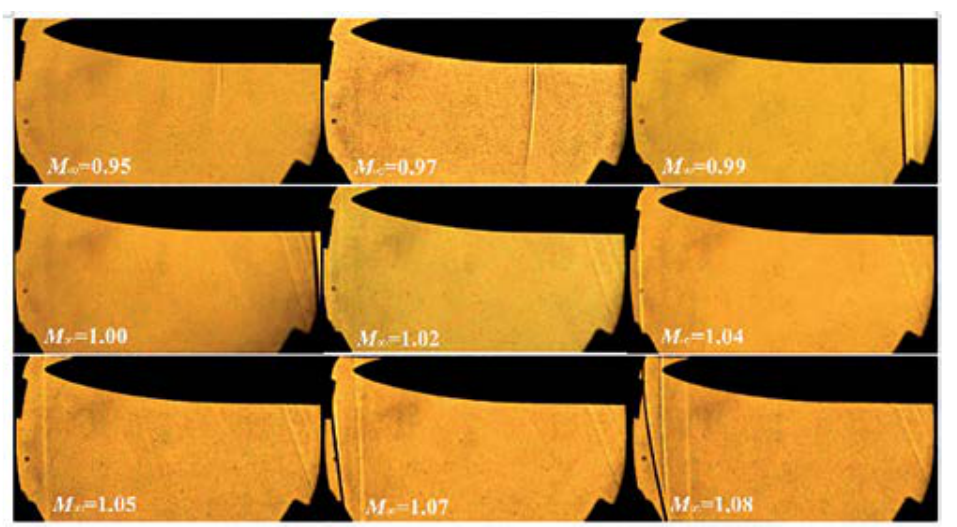
Figure 10. Schlieren images for model Haak forebody with a blockage area ratio of 0.78% for